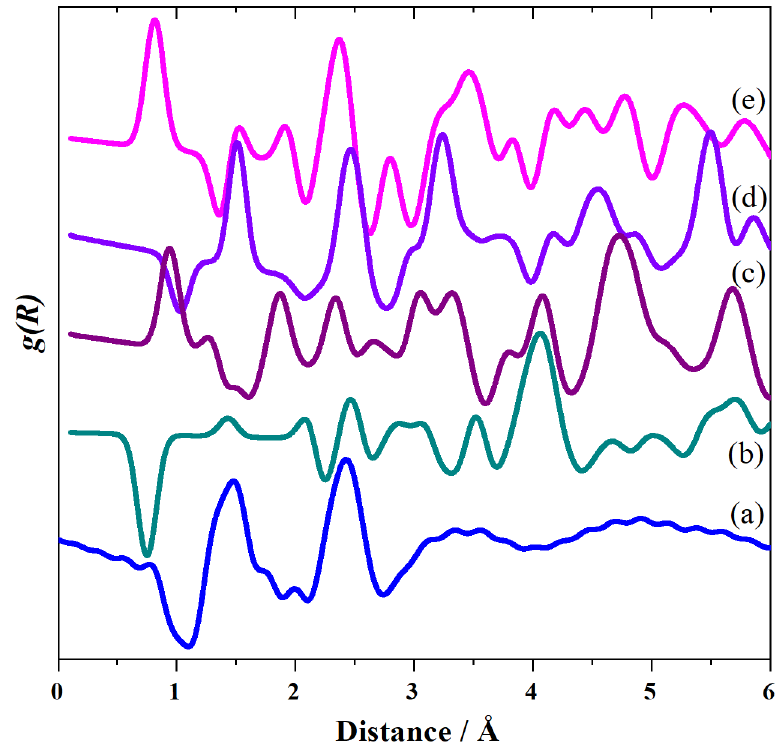
Figure 7. Radial distribution functions, g(R) , of CsHSO 4 in phase I: ( a ) this work and generated from the structures of: ( b ) Merinov [11], ( c ) Nozik et al . [4], ( d ) Beluskin et al . [7] and ( e ) Jirak et al . [9].